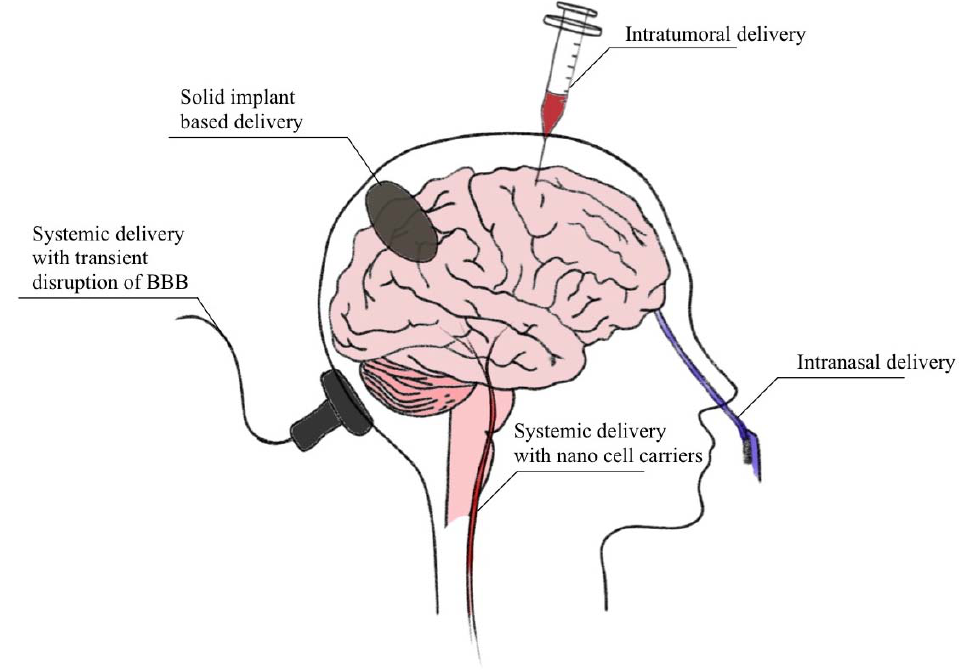
Figure 1. A graphic representative of current brain drug delivery techniques.